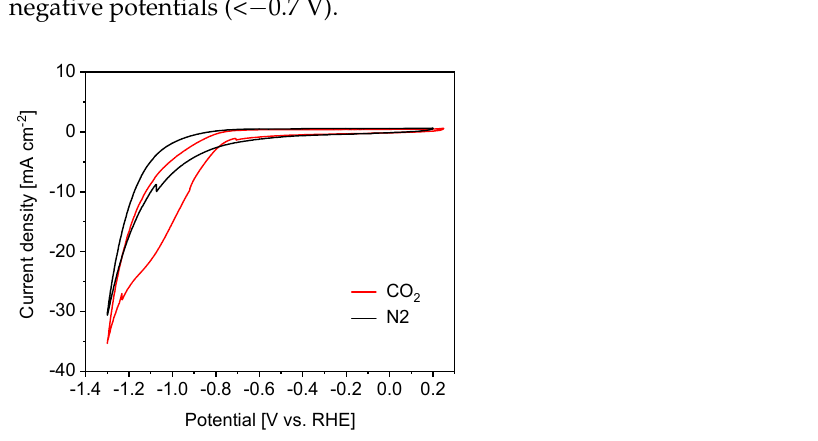
Figure 5. Cyclic voltammograms of the biochar-Bi 2 O 3 electrode in CO 2 - and N 2 -saturated 2.0 M KHCO 3 electrolyte.